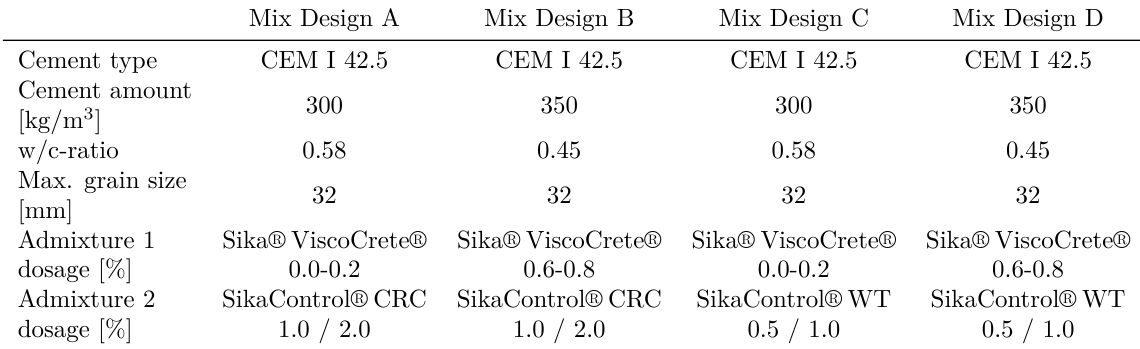
Table 2. Concrete Mix